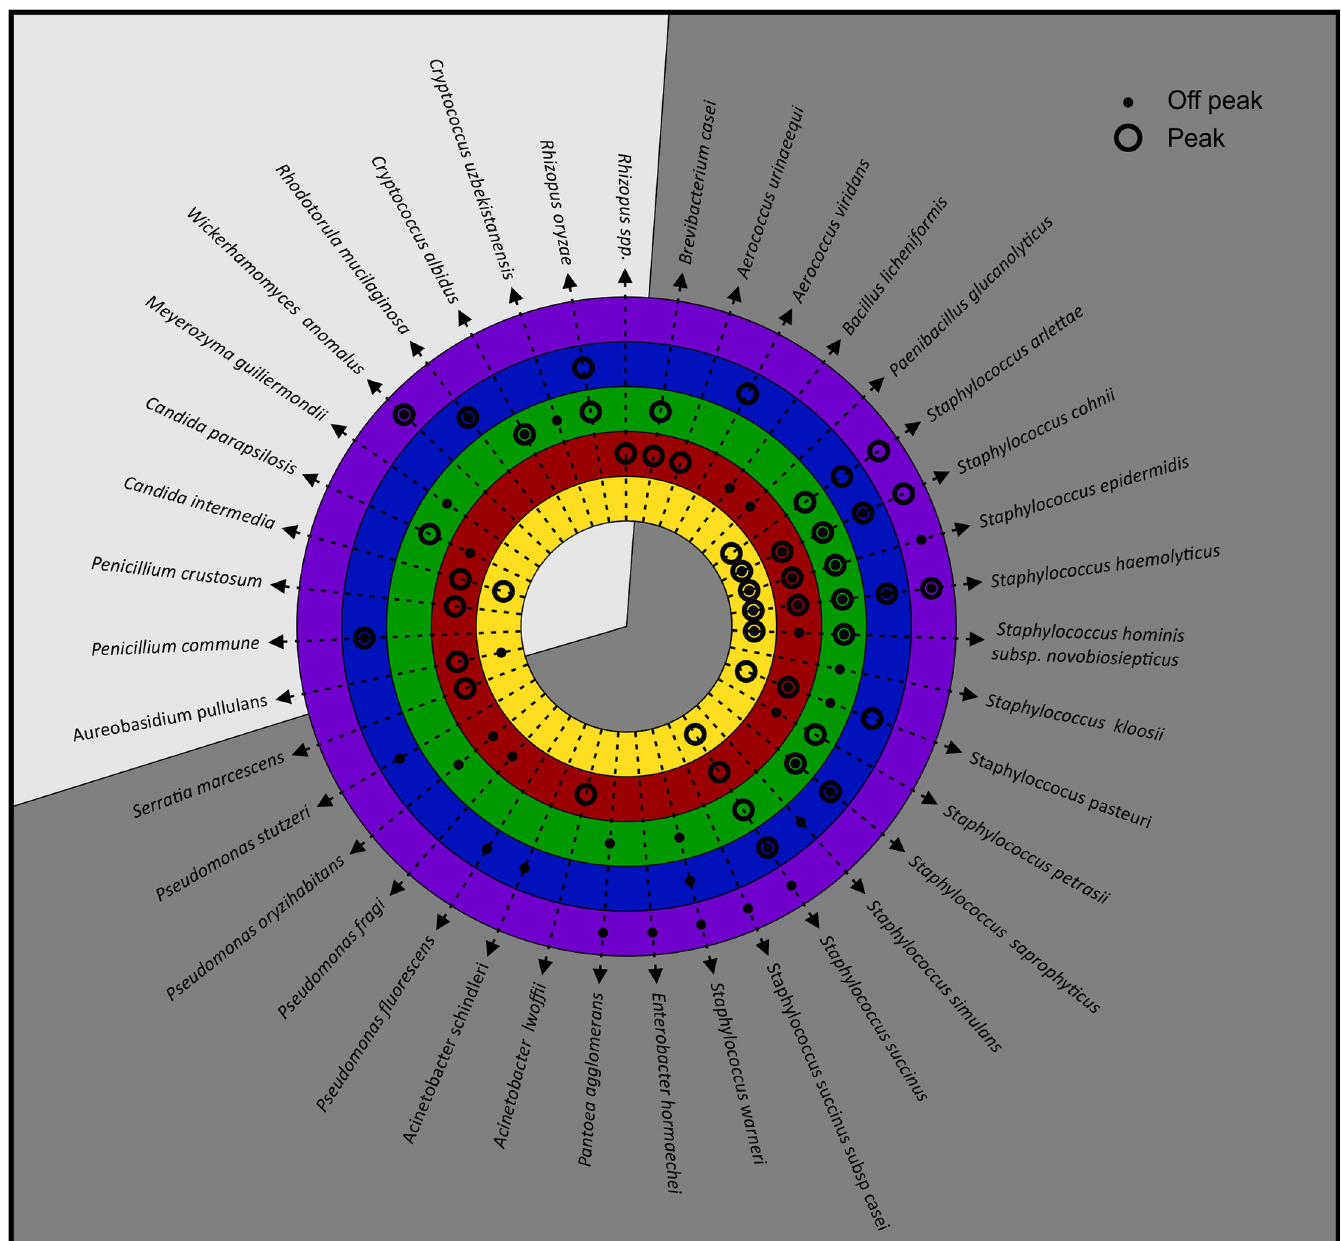
Fig 5. Harmful bioaerosols detected in samples from the different designated areas: Entrance to the production area (Area 1: Yellow), preparation and mixing of materials (Area 2: Red), between the production lines (Area 3: Green), dispersion of bottles (Area 4: Blue) and filling of the final product (Area 5: Purple). Sampling occurred during peak season (onset of summer) and off-peak season (onset of autumn) to establish if seasonal variation would impact the accumulation and spread of the harmful bioaerosols. Bacteria are represented by the dark grey region and the yeast and mould are represented by the light grey region.